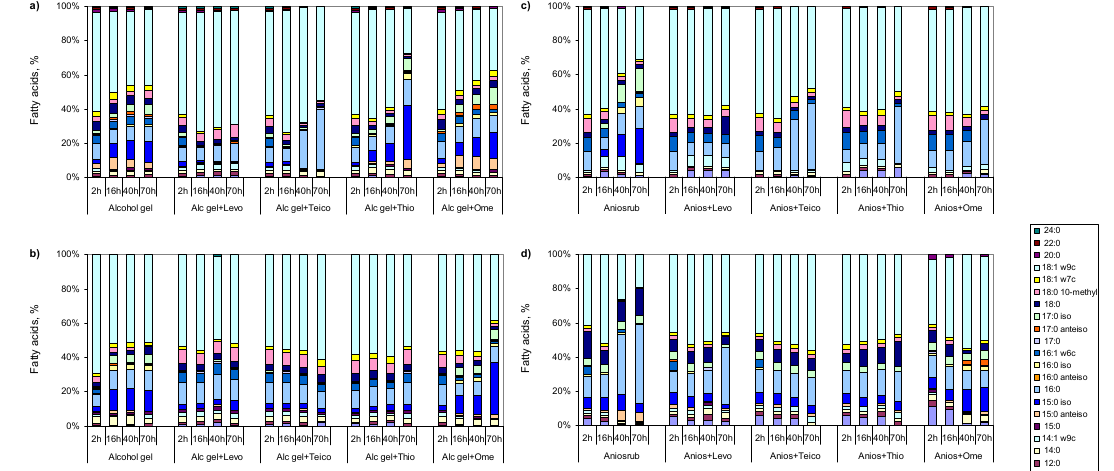
Figure 4. Fatty acid composition of non ‐ adapted cells of M. vaccae ( a , c ) and previously adapted cells to alcohol gel ( b ), and Aniosrub ( d ), when exposed to the disinfectants (alcohol gel, a,b; Aniosrub, c,d), antibiotics, and efflux pump inhibitors. The antibiotics tested were levofloxacine (Levo), teicoplanin (Teico), and the efflux pump inhibitors were thioridazine (Thio), and omeprazole (Ome). Only FA accounting for at least 1% of total lipids are represented. The content of each fatty acid presented here may be found in Table S4.